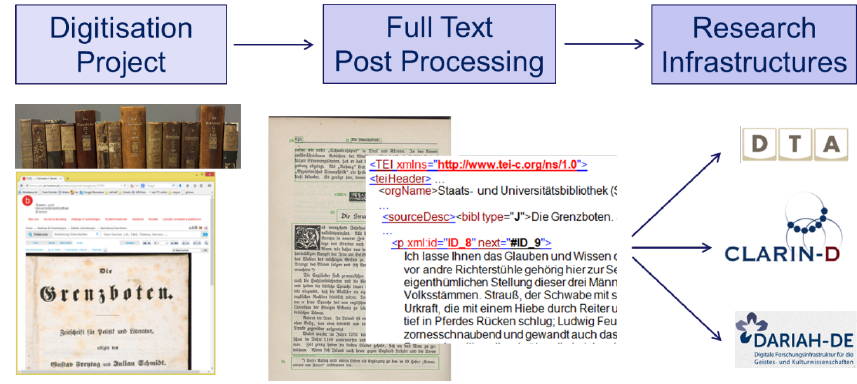
Fig. 1 Transfer of full text from a finished digitization project to research